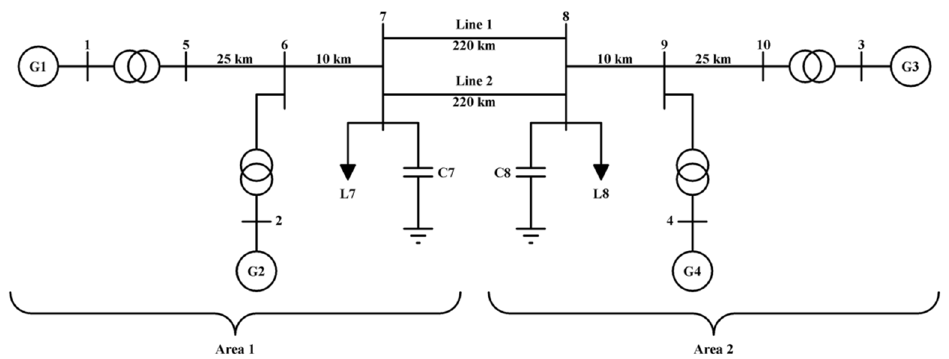
Figure 15. Four-machine, two-area power